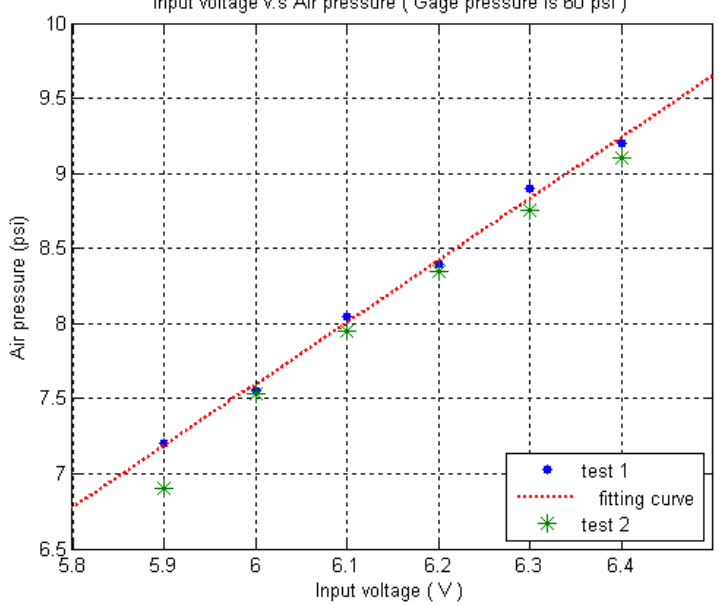
Figure 5. The linear relationship between input voltage and air pressure difference under the constant supply